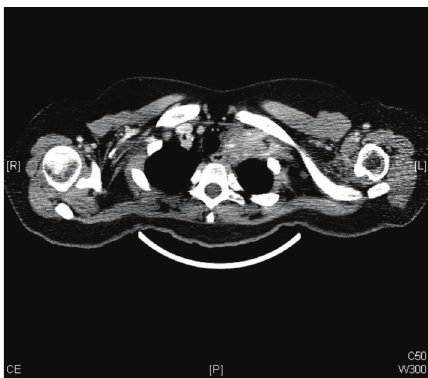
Figure1:Computedtomography(CT)axialimagesofneckshowing left supraclavicular solid mass of size 3.2 × 2.5 cm encasing the vessels.